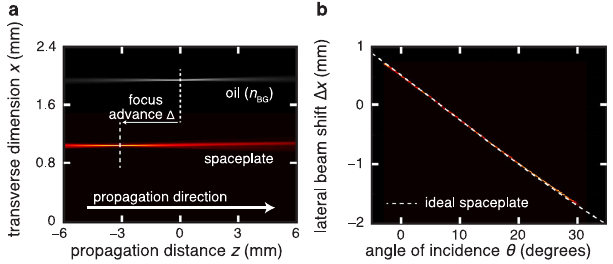
(gray). A converging beam comes to focus in oil at z = 0. Bottom